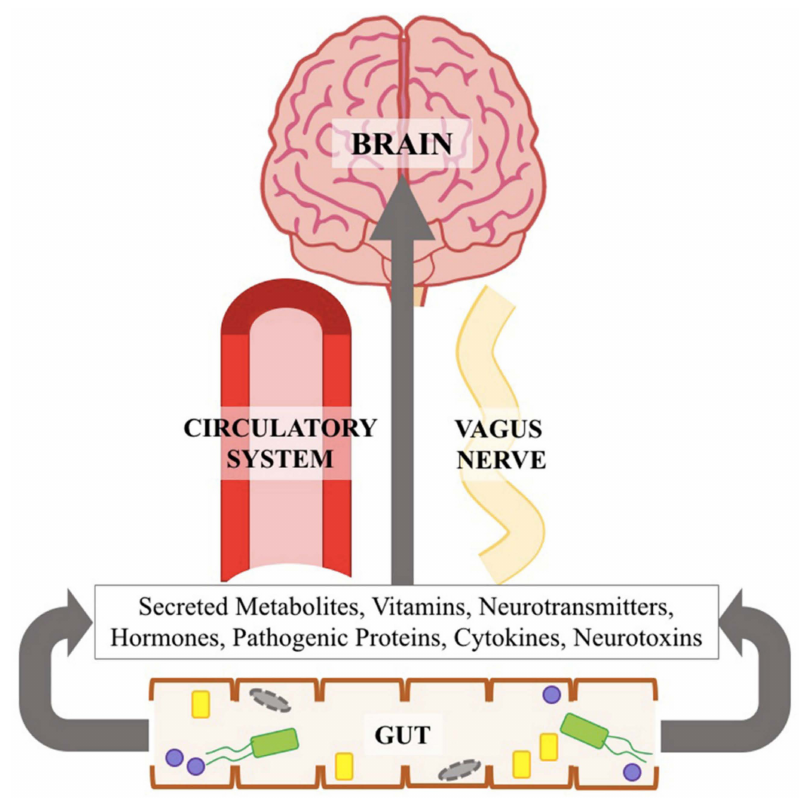
Figure 1. Communication between the gut microbiota and the brain [43] (reused with permission, license number: 4637571224608, Elsevier and Copyright Clearance